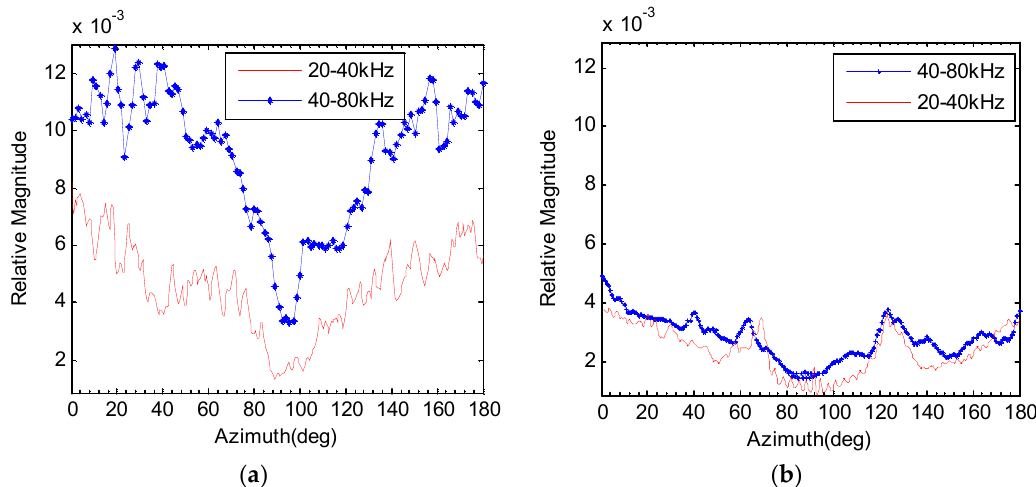
Figure 18. ( a ) Fluctuation intensity comparison of the real target wideband echo envelope with different frequencies, the pulse length is 1 ms; ( b ) fluctuation intensity comparison of the synthetic wideband echo envelope with different frequencies, the pulse length is 1 ms.